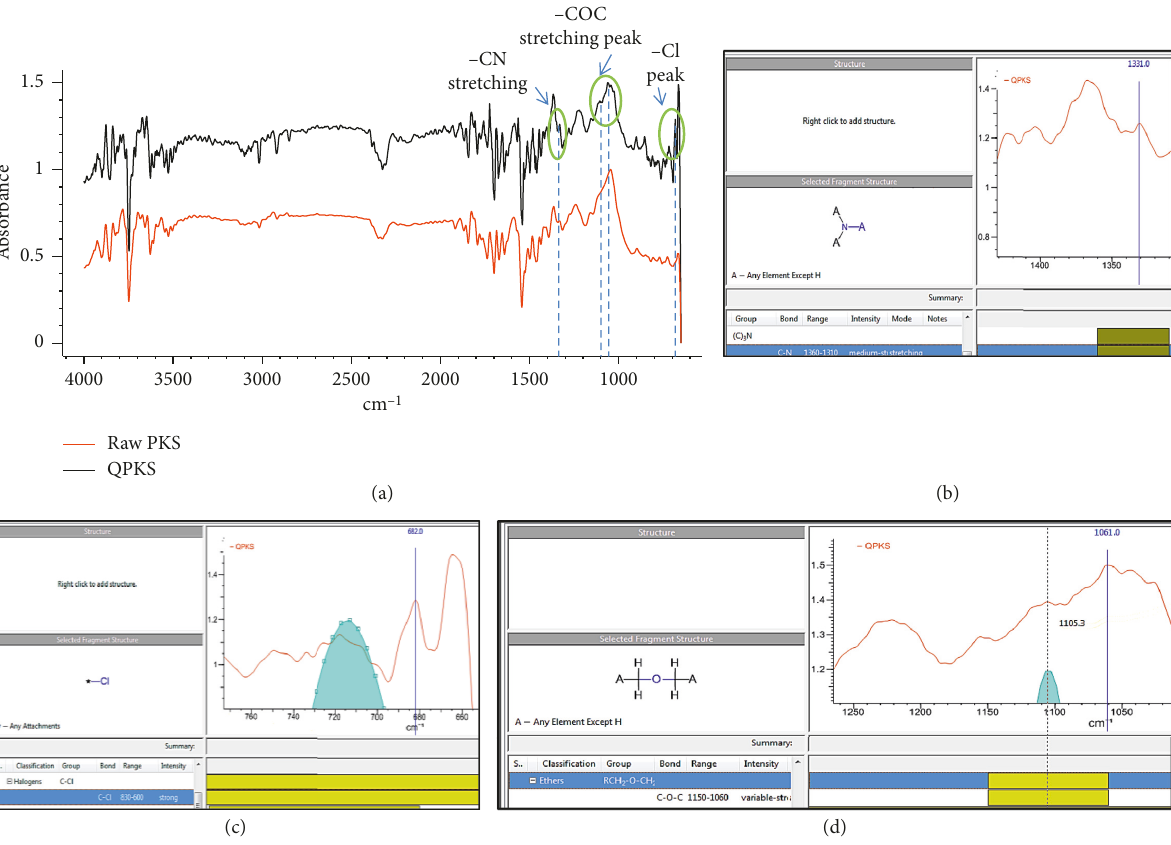
Figure 3: FTIR spectra of (a) raw PKS and QPKS, (b) peak of–CN, (c) peak of Cl, and (d) peak of